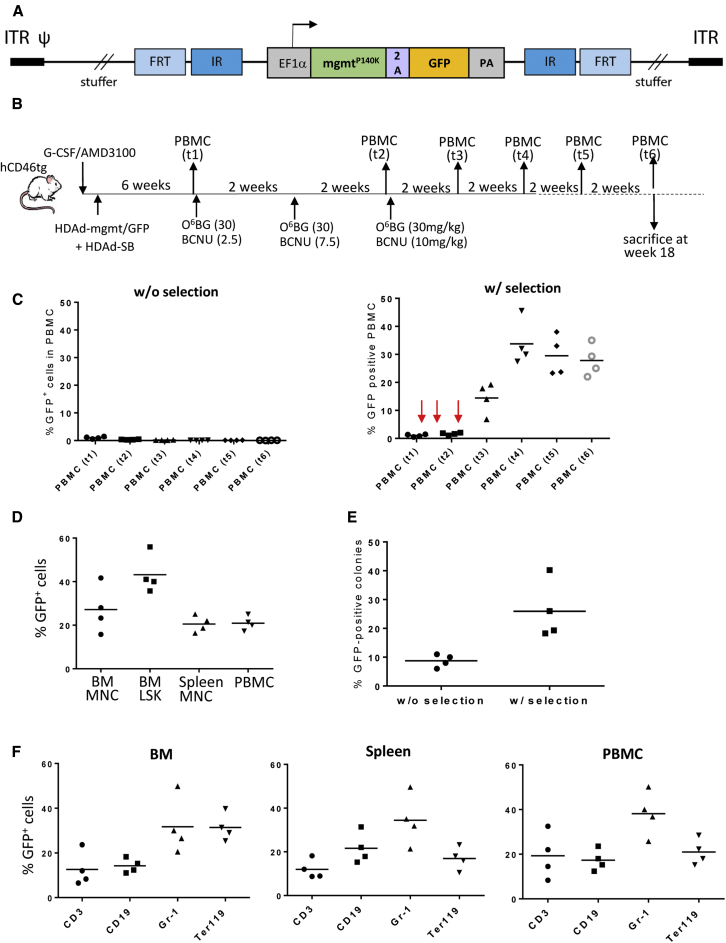
In Vivo Selection of In Vivo-Transduced HSCs(A) Vector design. The mgmtP140K gene is linked to the GFP gene through a self-cleaving picornavirus 2A peptide. Both genes are under the control of the EF1α promoter. PA, poly-adenylation signal. The transgene cassette is flanked by inverted repeats (IR), which are recognized by the SB100x transposase, and frt sites, which are recognized by the Flp recombinase. (B) Treatment regimen. hCD46tg mice were mobilized and i.v. injected with HDAd-mgmt/GFP + HDAd-SB (2 times each, 4 × 1010 vp of a 1:1 mixture of both viruses). 4 weeks later, PBMCs were harvested before O6-BG/BCNU treatment was started (time point “PBMC [t1]”). This cycle was repeated every 2 weeks for a total of 3 times. With each cycle, the BCNU concentration was increased from 2.5 mg/kg to 7.5 mg/kg and 10 mg/kg. GFP marking was followed until week 18, when animals were sacrificed for GFP analysis in other tissues. (C) Percentage of GFP+ PBMCs in mice without O6-BG/BCNU treatment (left panel) and with drug (right panel). O6-BG/BCNU treatment is indicated by vertical red arrows. The PBMC collection time points (“PBMC [t1] to PBMC [t6]” are shown in B). (D–F) Week 18 analyses. Percentage of GFP+ MNCs and LSK cells in bone marrow (BM), splenic MNCs, and PBMCs (D). GFP+ colonies. Total bone marrow lin− cells were plated, and GFP expression in colonies was analyzed 12 days later. Each symbol is the average GFP+ colony number for individual mice. The total number of colonies that developed was comparable for mice with and without in vivo selection (E). GFP+ cells in CD3, CD19, Gr-1, and Ter119 lineage-positive cells in bone marrow, spleen, and PBMCs (F).